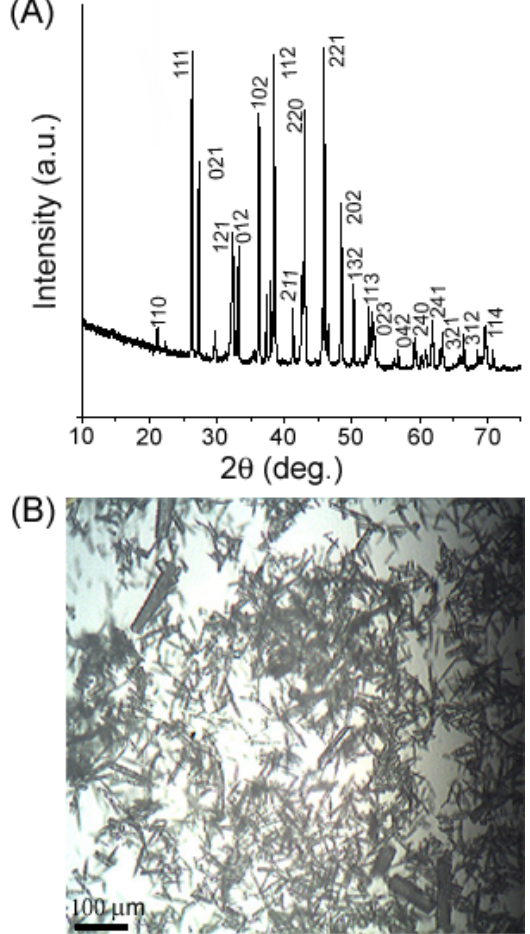
Figure 1. X-ray diffraction (XRD) pattern ( A ) and optical microscopy image ( B ) of the as-grown aragonite